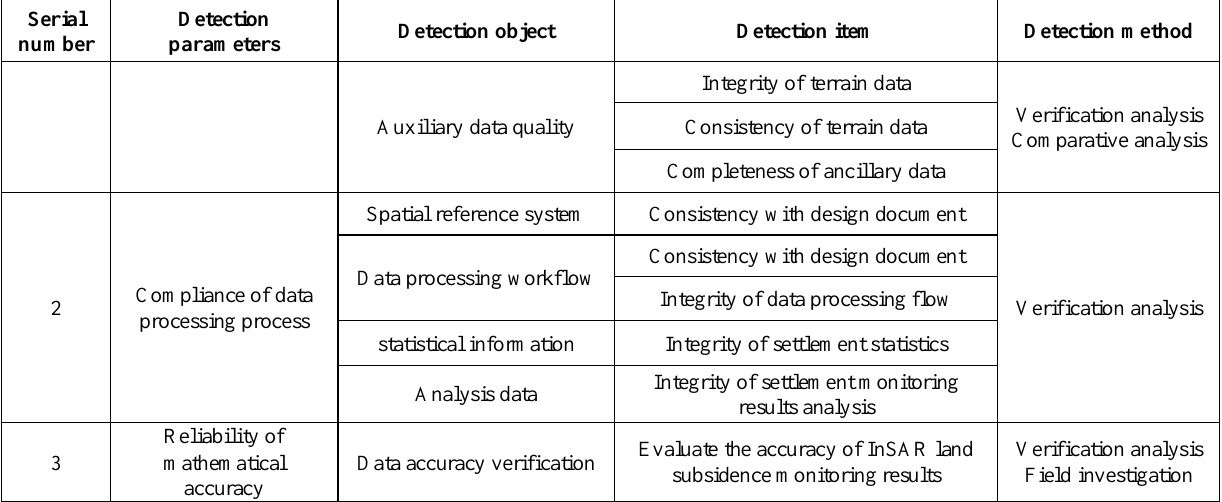
Table 1. Contents and Test Methods of the Deformation Monitoring Result of PS-InSAR